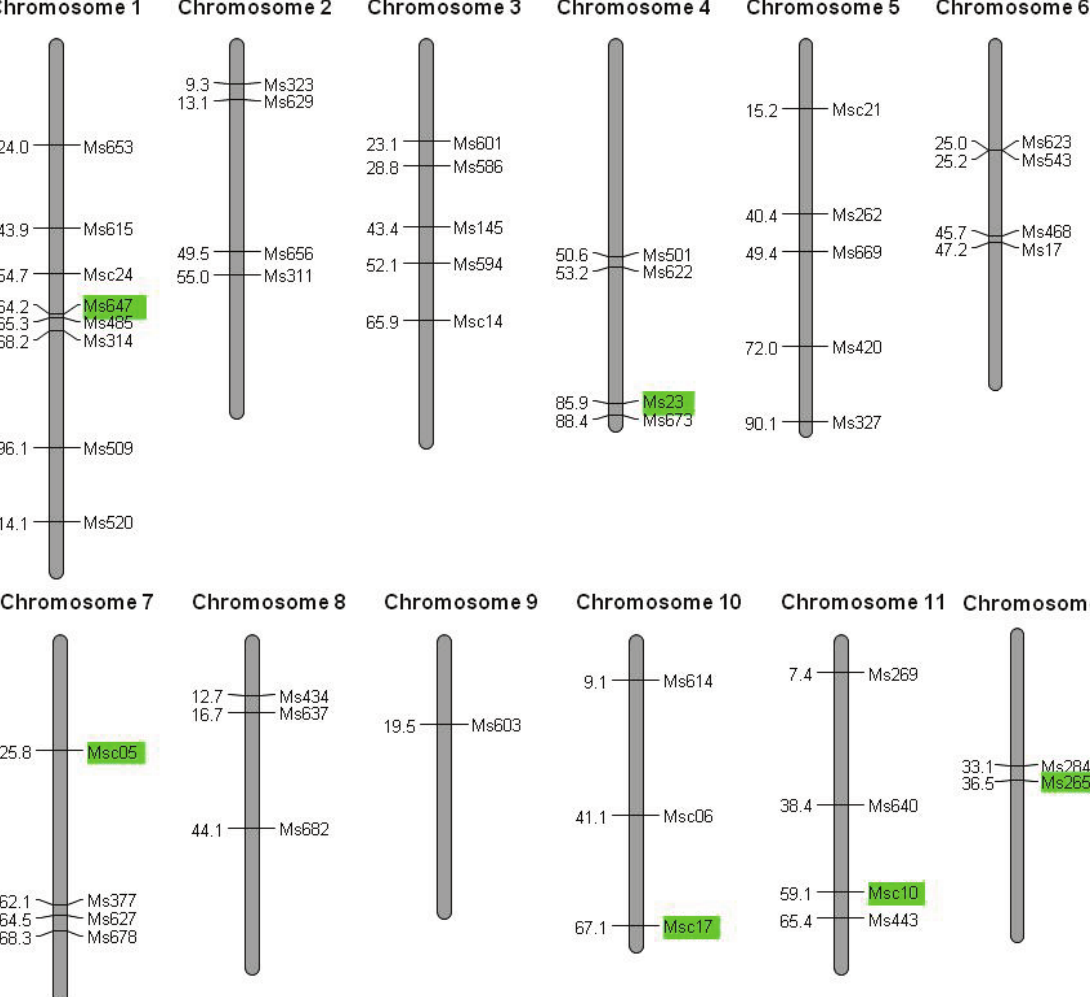
Figure 2. Hawaiian monk seal microsatellites mapped onto the dog genome. Polymorphic microsatellites are color coded according to an F (yellow = balancing selection; green =